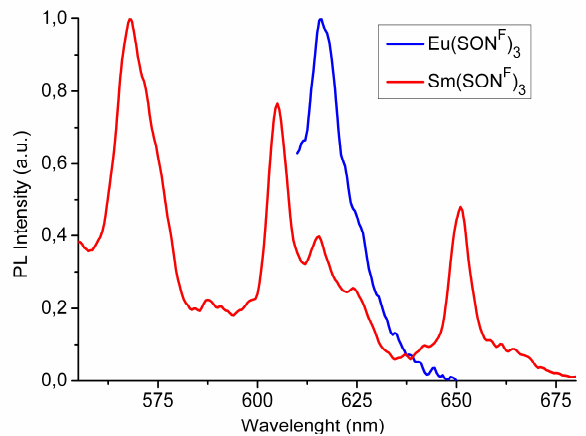
Figure 8. Normalized PL spectra of the complexes 4 and 5 ( λ exc = 395 nm) in a THF solution (10 − 4